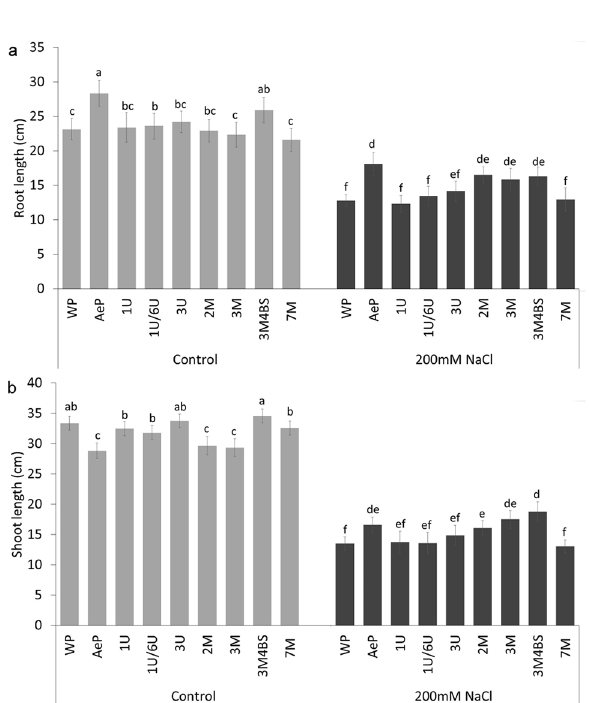
Figure 3. Growth responses of different genotypes grown in hydroponic solution with and without salt treatment. Root length ( a ) and shoot length ( b ) of plants. WP—wheat parent; AeP— Aegilops parent; Data are mean ± standard deviation of 10 replicates per treatment and genotypes. Different letters indicate significant differences between the genotypes at p < 0.05 using Tukey’s post hoc